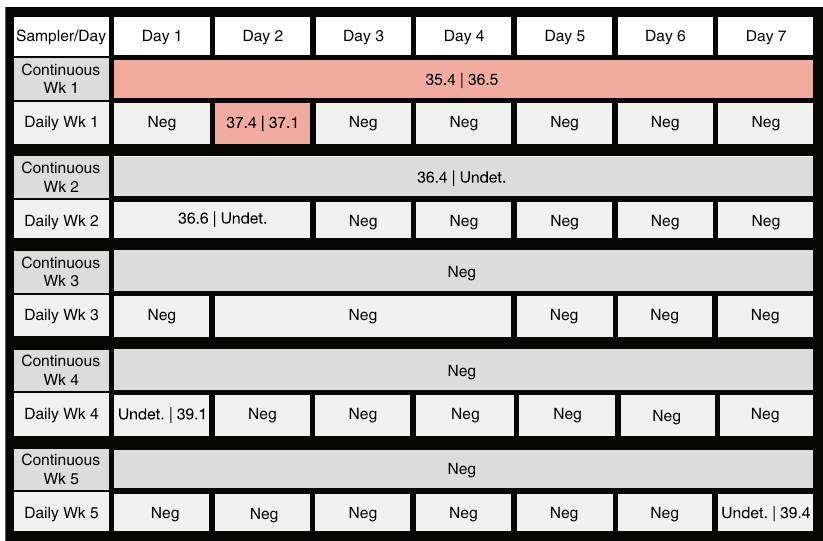
Fig. 2 | Comparison ofSARS-CoV-2 RT-qPCR results fromcontinuous and daily airsampling intervals. Two adjacentThermo Scienti fi cAerosolSenseinstruments wereruncontinuouslyordailyoverseveraldays.SARS-CoV-2genomicmaterialwas detectedbytwoseparateRT-qPCR CDC assays.If the cyclethresholdvaluesof one or both N1 and N2 assays were less than 40, the Ct values are shown in the box